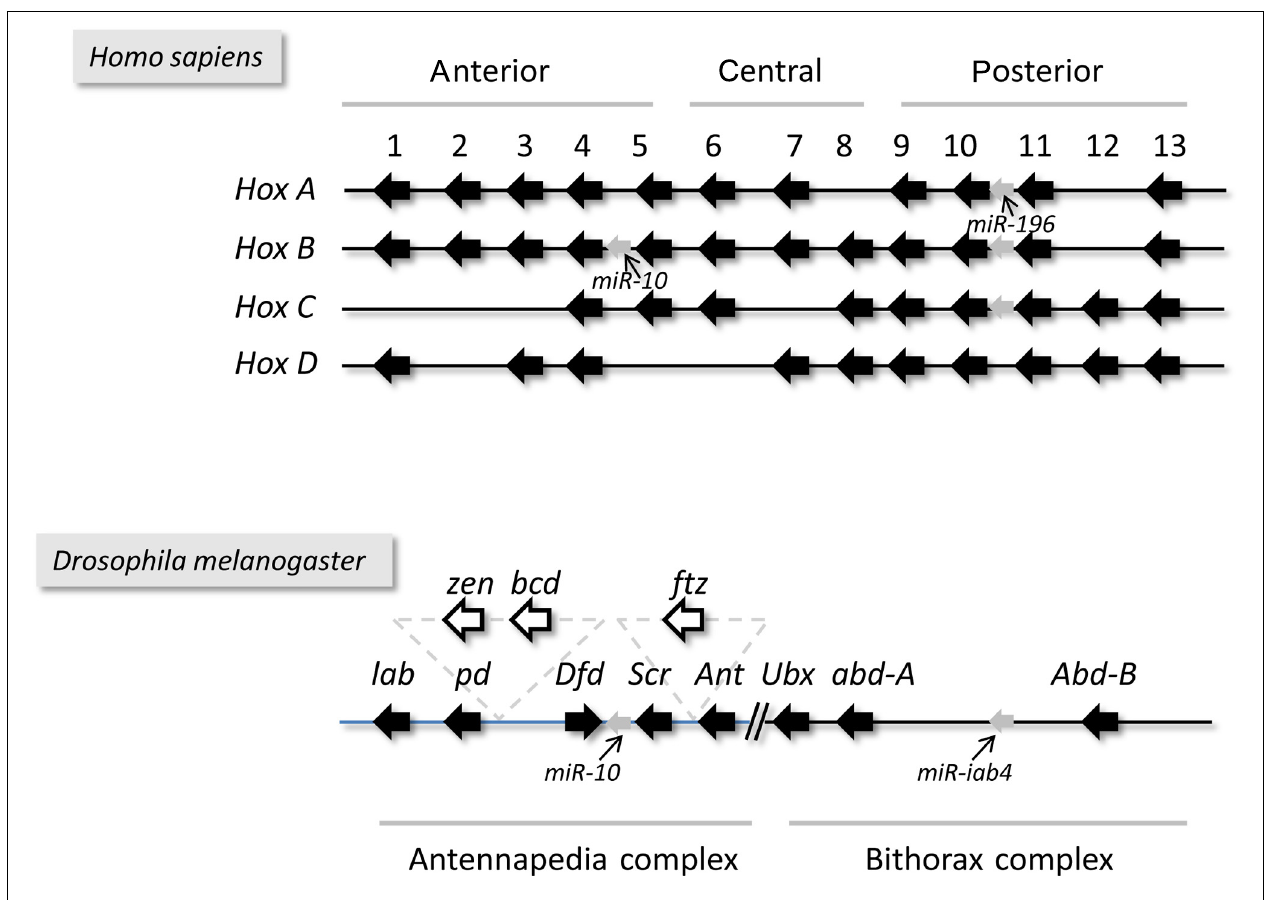
FIGURE 2 |The structural organization of the pseudorabies virus genome. The genome of PRV is atypical among alpha-herpesviruses because it does not have inverted repeat sequences around the Ul region. Color code: light grey, immediate early gene (i.e., 180 gene); black, early genes; dark grey, E/L genes; white, L